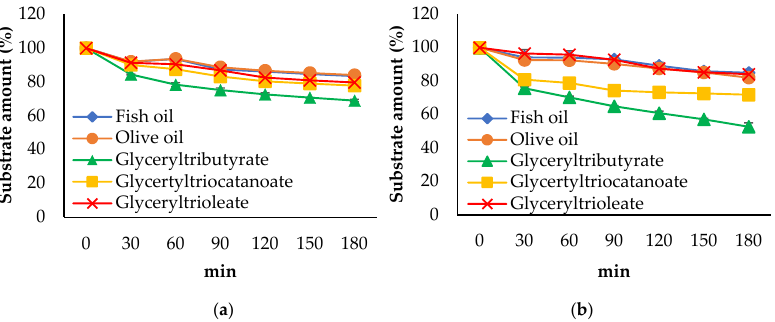
Figure 12. Lipid hydrolysis activities of Est2L ( a ) and Est4L ( b ), using a pH shift assay. Enzyme activities were measured at 1% substrates in 20 mM Tris-HCl (pH 8.0) by adding 0.1% phenol red.